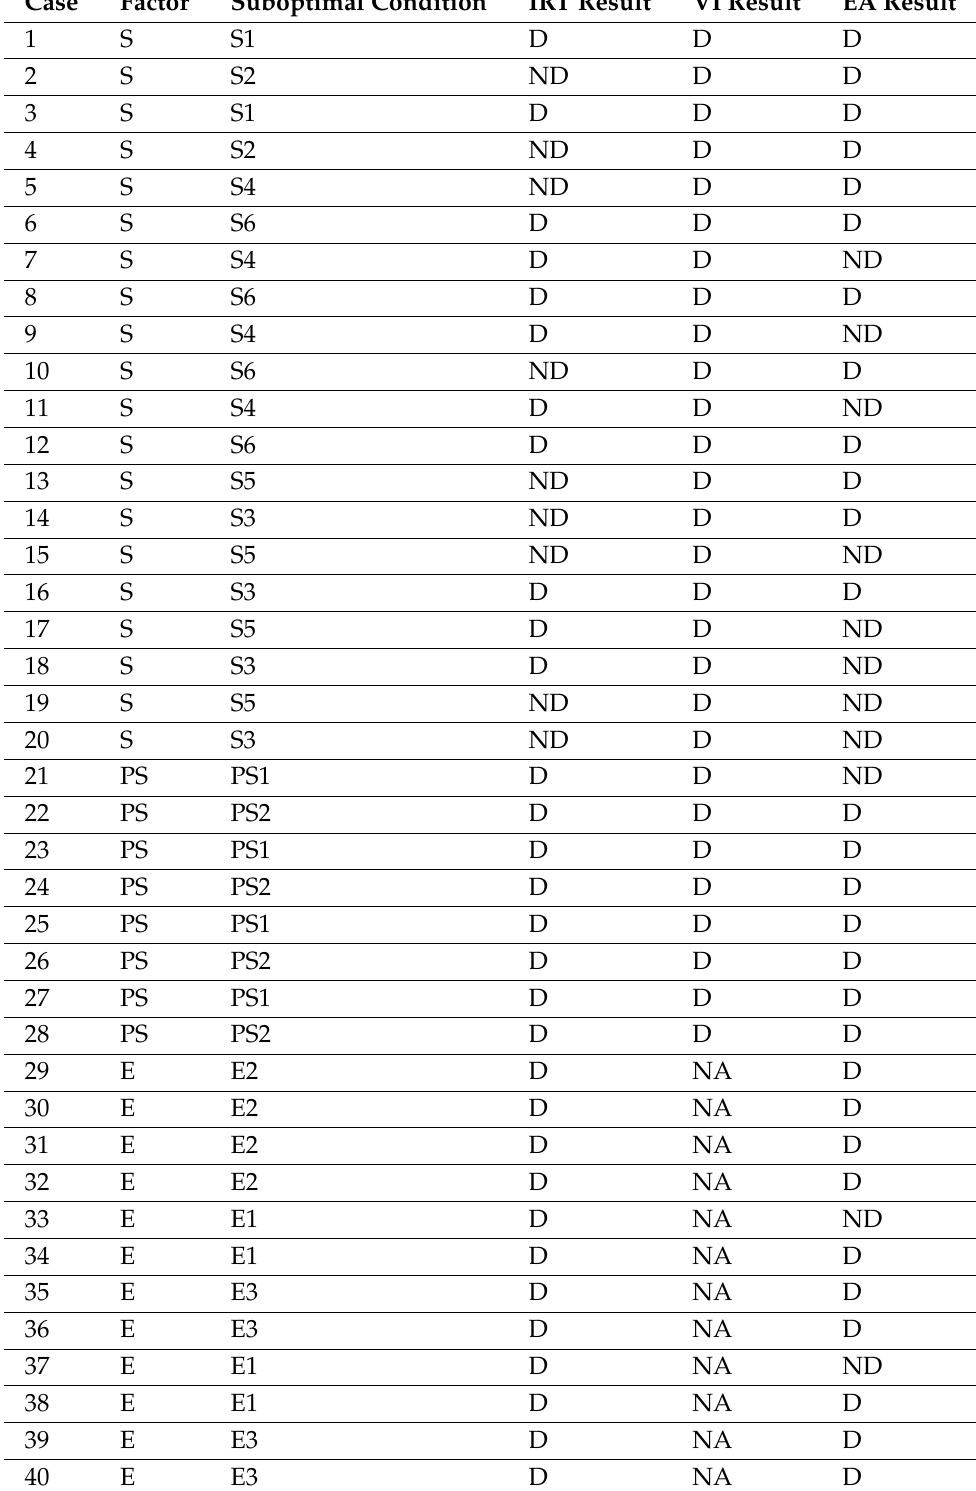
Table 6. Summary of the results of the experiment. D = Detected, ND = Not detected, NA = Not apply, S = soiling, PS = partial shading and E = electrical fault.